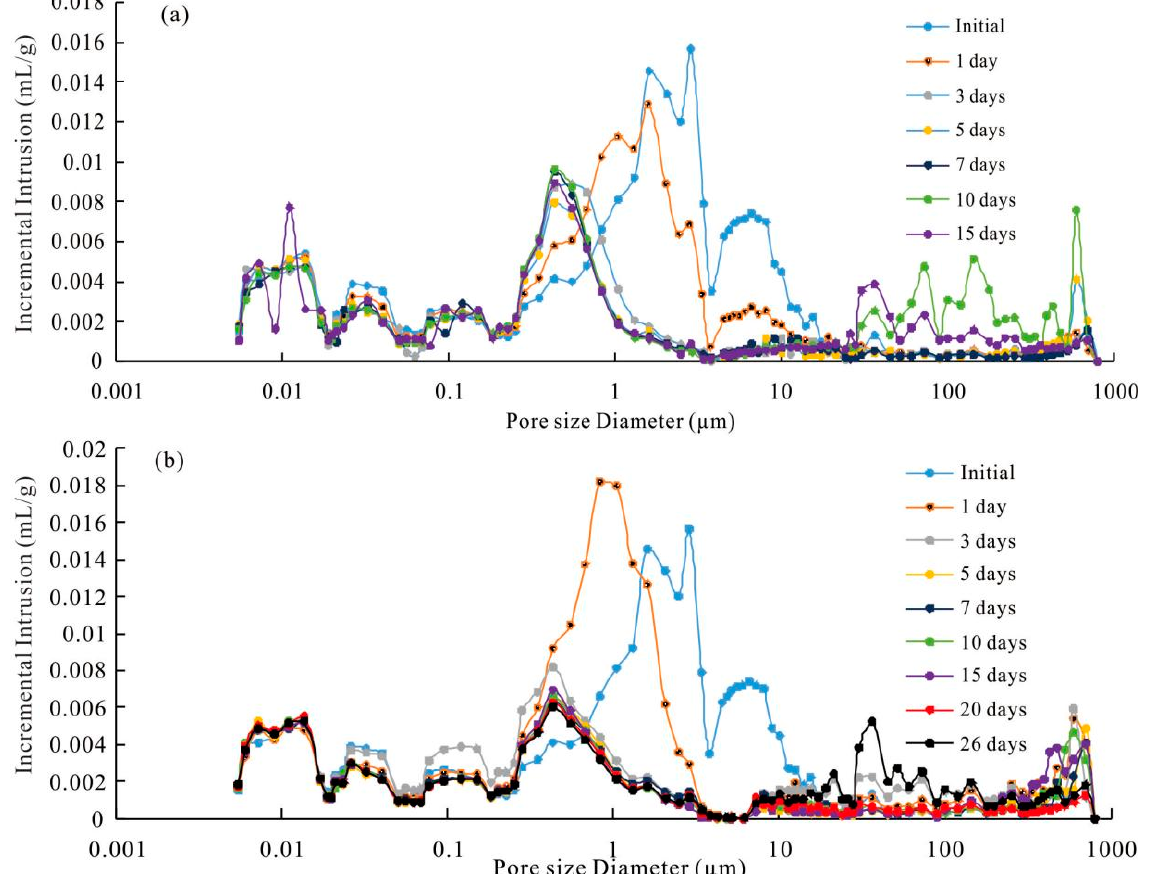
Figure 5. The relationship between the pore size distribution of expansive soil and the duration of dehydration under different environmental conditions ( a ) 50 °C-10%, ( b ) 50 °C-70%.